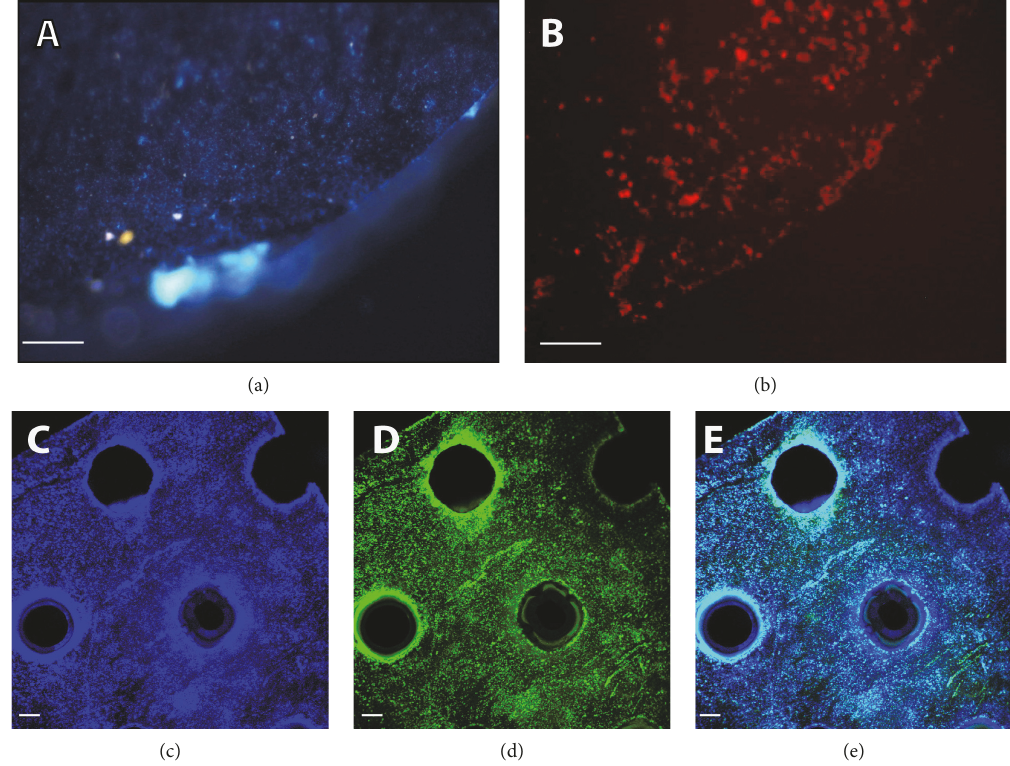
Figure 3: BDSCs osteogenic di ff erentiation with rapamycin and titanium sca ff olds. Nuclear and Alizarin Red S stainings on type 1 titanium after di ff erentiation by confocal microscopy analysis ((a) and (b), resp.). Nuclear staining, osteocalcin expression, and merge analysis on type 2 titanium sca ff old ((c), (d), and (e), resp.) (osteocalcin green, DAPI blue; (a), (b) bar =10 mm; (c), (d) 200 μ m